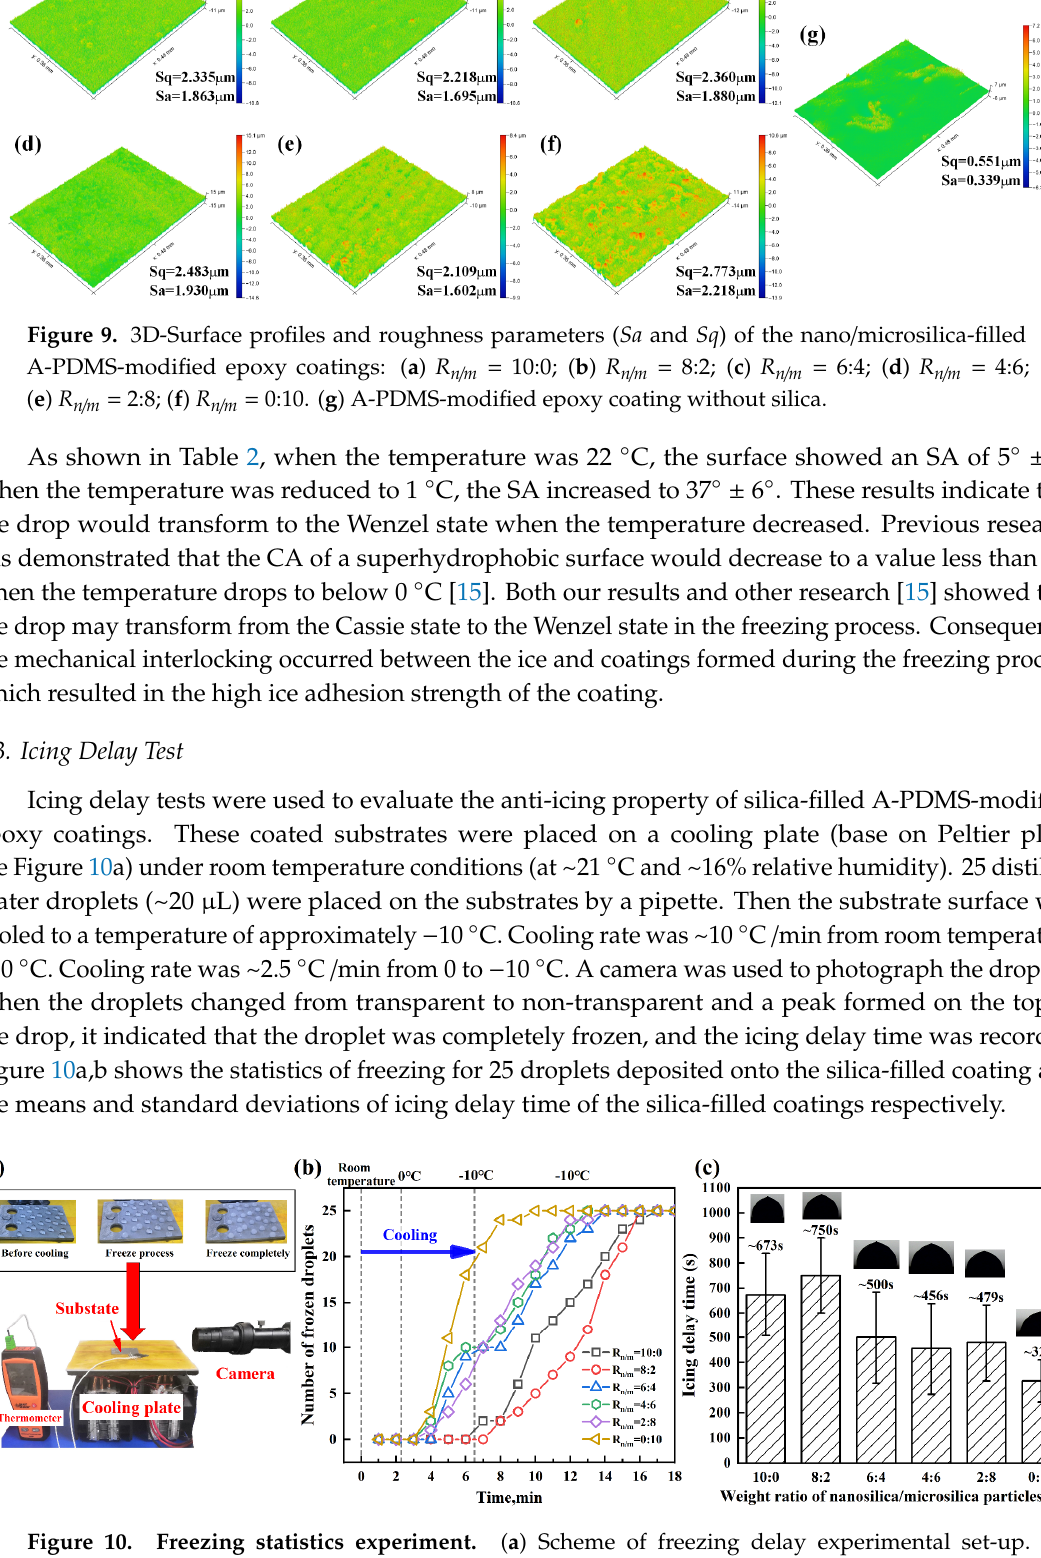
Figure 8. SEM images of the nano/microsilica-filled A-PDMS-modified epoxy coatings: ( a ) R n/m =10:0; ( b ) R n/m = 8:2; ( c ) R n/m = 6:4; ( d ) R n/m = 4:6; ( e ) R n/m = 2:8; ( f ) R n/m = 0:10. ( g ) A-PDMS-modified epoxy coating. Sessile and moving water drops are shown in the insets.